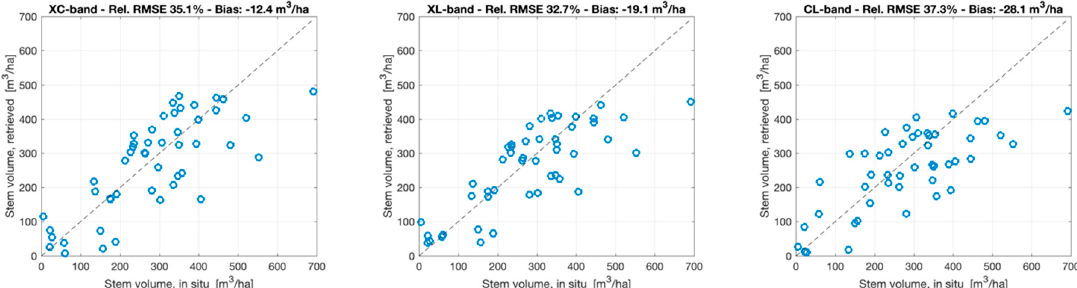
Figure 9. Scatter plots of measured and retrieved stem volume at Remningstorp for a combination of estimates obtained from all images acquired at two frequency bands.